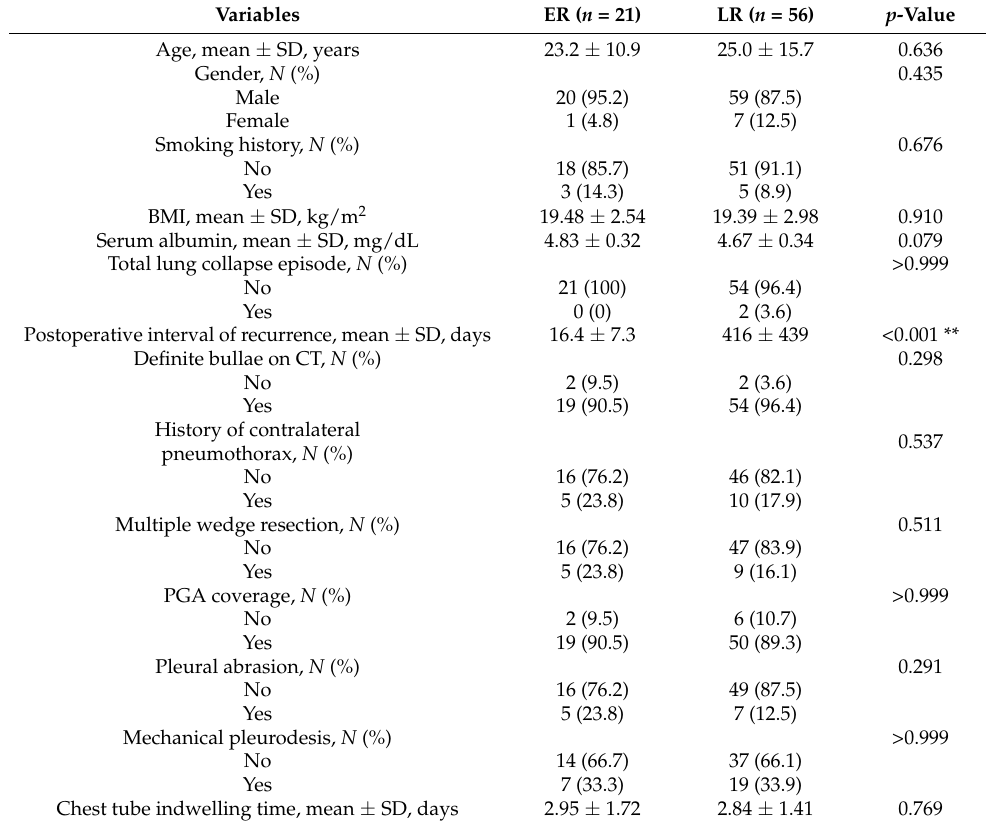
Table 1. Comparison of baseline characteristics between the early recurrence and late recurrence groups after surgery.